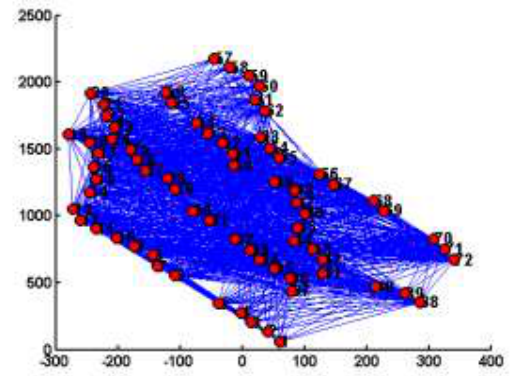
Fig. 7 Image topological graph computed with the conjunction